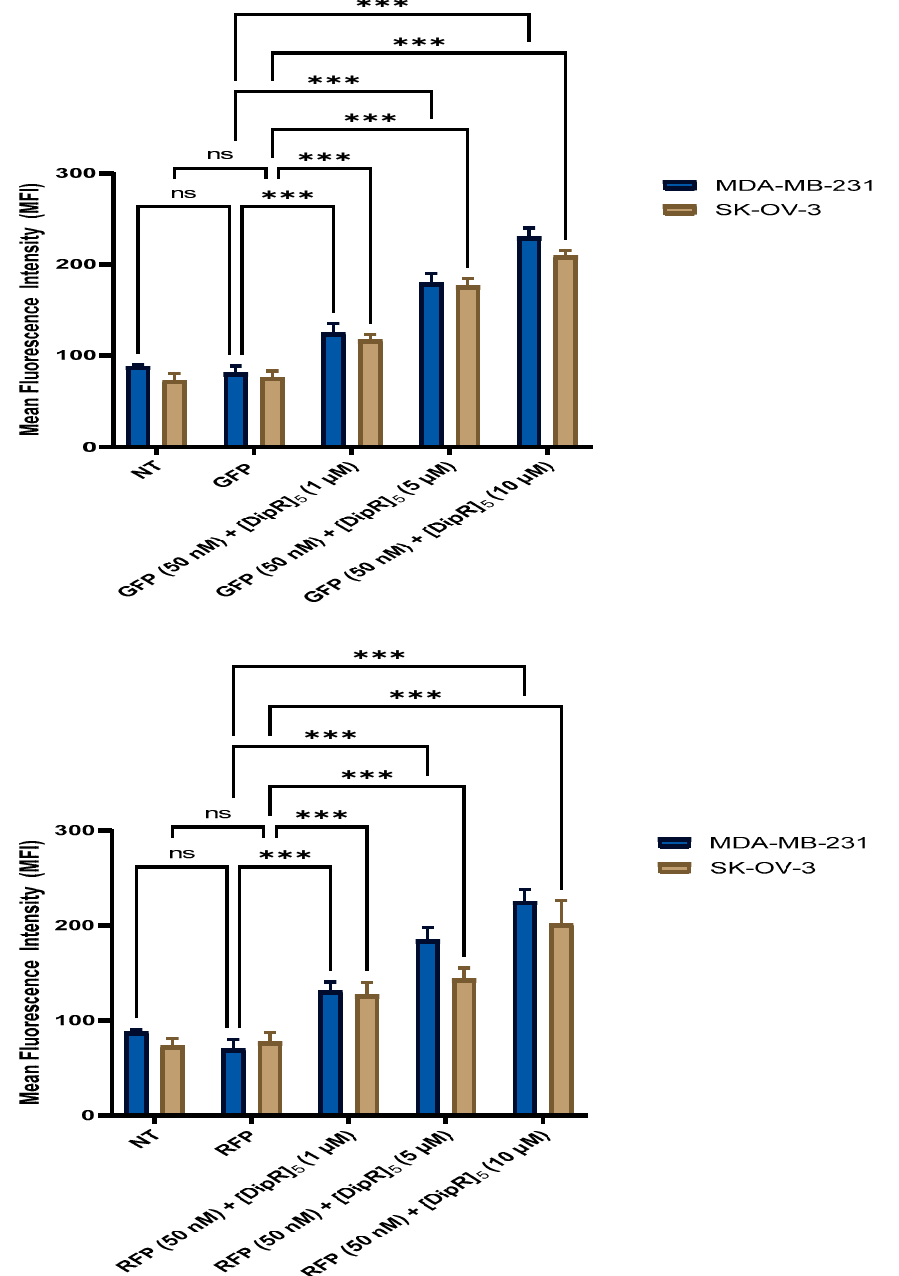
Figure 17. Cellular uptake of the GFP-[DipR] 5 mixture at a peptide concentration (1–10 µM) and GFP or RFP at (50 nM) for 3 h in MDA-MB-231 and SK-OV-3 cells studied by flow cytometry. The results are mean ± SD ( n = 3) (ns; no significance, *** p < 0.001), treatment vs. Ctrl (GFP alone). Mechanistic studies were performed to determine whether the cellular uptake of the GFP in the presence of [WR] 9 or [DipR] 5 is endocytosis-dependent. These studies were conducted by confocal microscopy (Figure S11) and quantitated by fl ow cytometry in MDA-MB-231 cells to measure the uptake of GFP in the presence of peptides [WR] 9 and [DipR] 5 and various endocytosis inhibitors, including chlorpromazine, chloroquine, me- thyl- β -cyclodextrin, and nystatin. MDA-MB-231 cells were preincubated by various endo- cytosis inhibitors for 30 min. Then, the cells were incubated with GFP (50 nM) with [WR] 9